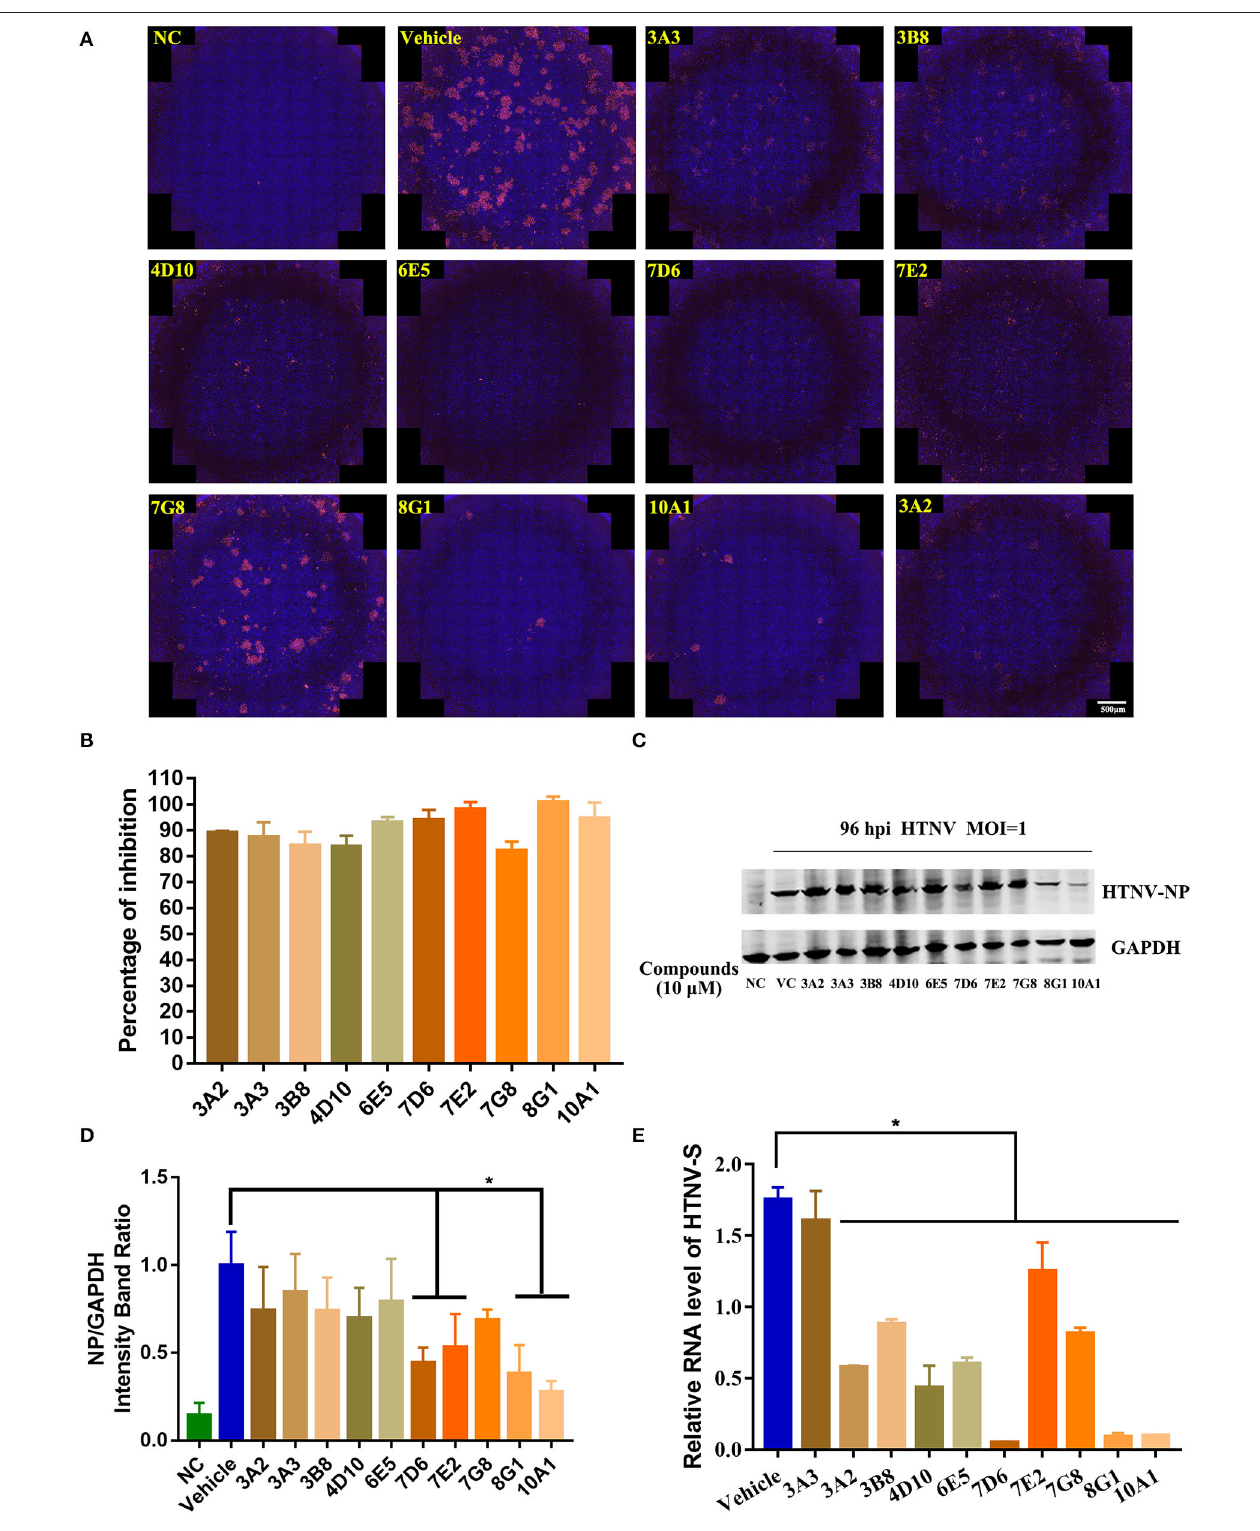
FIGURE 2 | Identification of potential kinase inhibitor candidates with in vitro anti-HTNV activity. (A) Immunofluorescence staining of HTNV nucleocapsid protein after the 10 protein kinase inhibitors treatment, NC, negative control, Vehicle: Vehicle-treated control, scale bar = 500 µ m. (B) Inhibitory percentage of protein